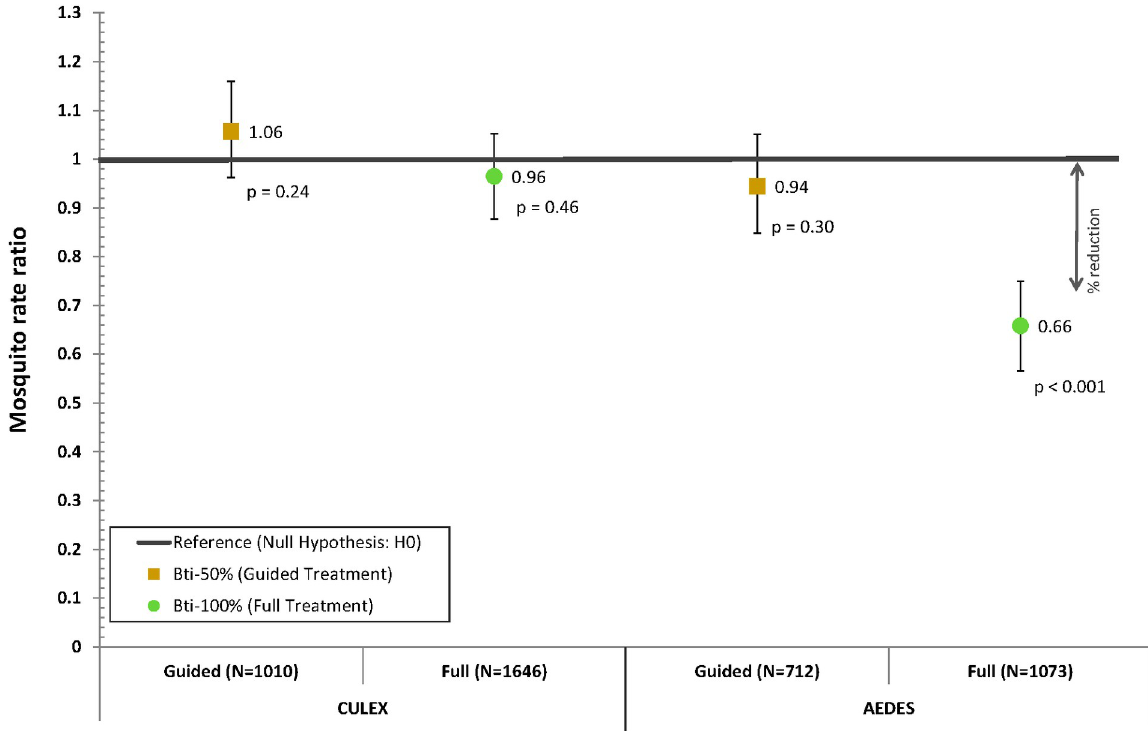
Fig 3. Point estimates of the regression model for the intervention year compared to the baseline year indicating the reduction in the counts of female Culex and Aedes mosquitoes achieved through different larviciding options with Bti , i.e. guided ( Bti -50%) or full treatment ( Bti -100%) of Anopheles larval habitats treated in rural villages, excluding the town of Nouna. The reference line represents the rate ratio value under the null hypothesis: i.e. the count of female mosquitoes in the control areas receiving no Bti treatment are not significantly different from the counts in areas receiving a guided or full Bti